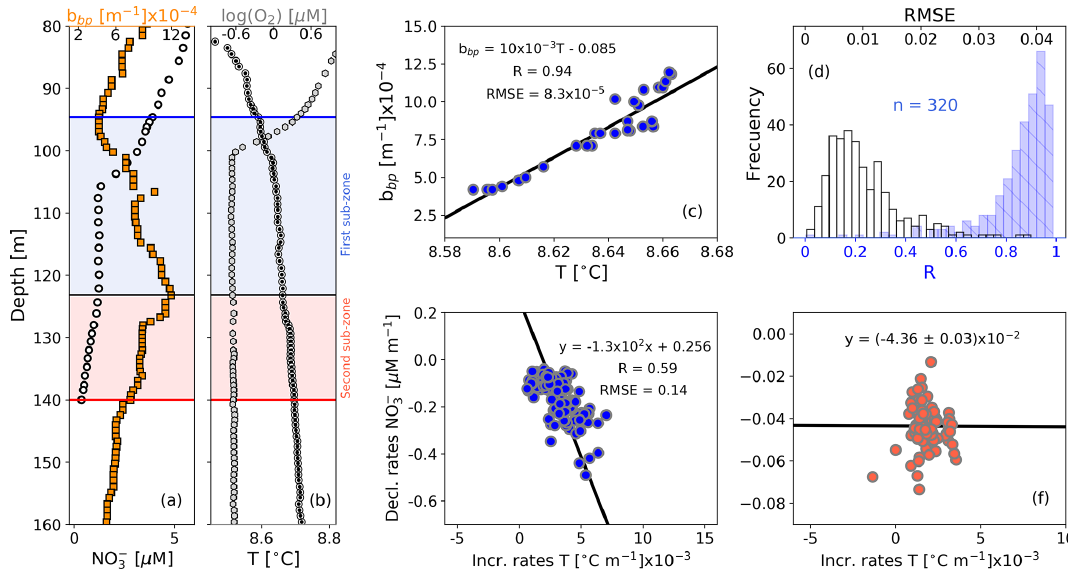
Figure 4. Float profiles of (a) NO − and b bp and (b) T and log ( O 2 ) collected on 10 September 2017. Horizontal blue and red lines in (a) 3 and (b) are the top and bottom of the OP DA . The b bp maximum is indicated in (a) and (b) as horizontal black lines. The first and second sub-zones of the OP DA are, respectively, highlighted in (a) and (b) as blue and red squares. (c) b bp vs. T for the first sub-zone of the profile in (b) . (d) Frequency distributions of correlation coefficients ( R , blue bars) and root mean square errors (RMSE, white bars) for b bp vs. T in the first sub-zone, including data collected by the three floats. Decrease rates of NO − vs. increase rates of T in (e) the first sub-zone and 3 (f) the second